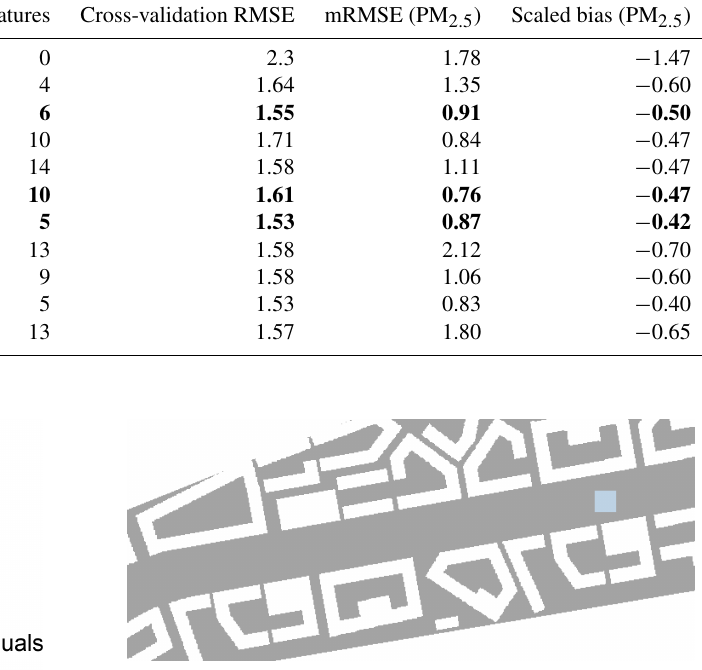
Figure 6. Example of a single evaluation segment (light blue square) applied in the concept drift analysis for KA20 using the Drifter